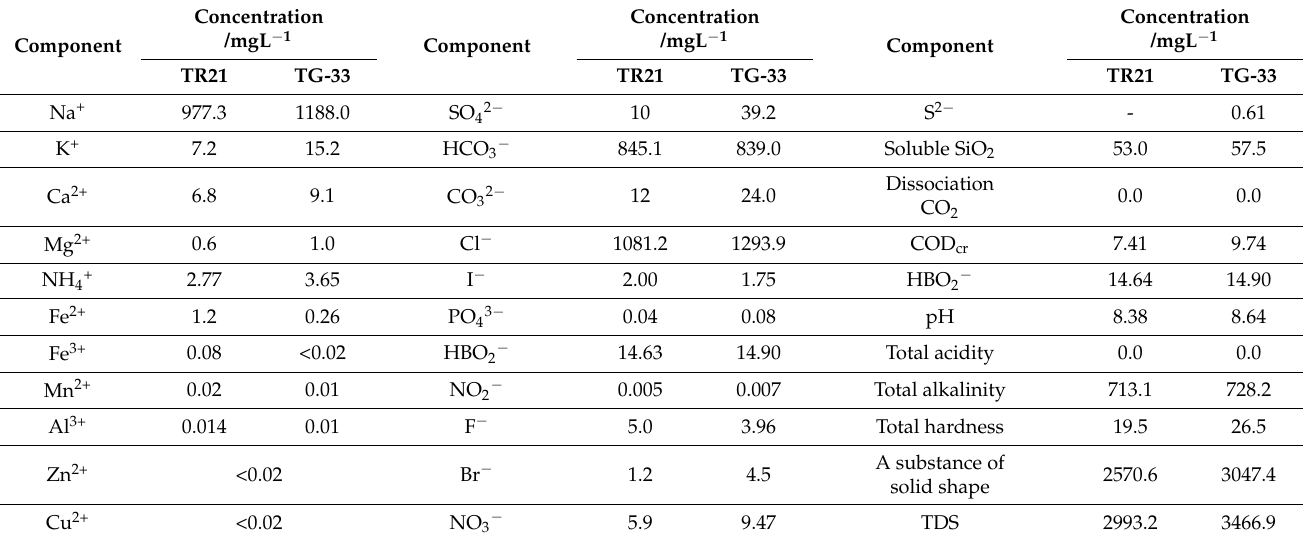
Table 3. Major chemical composition table of Dongying geothermal